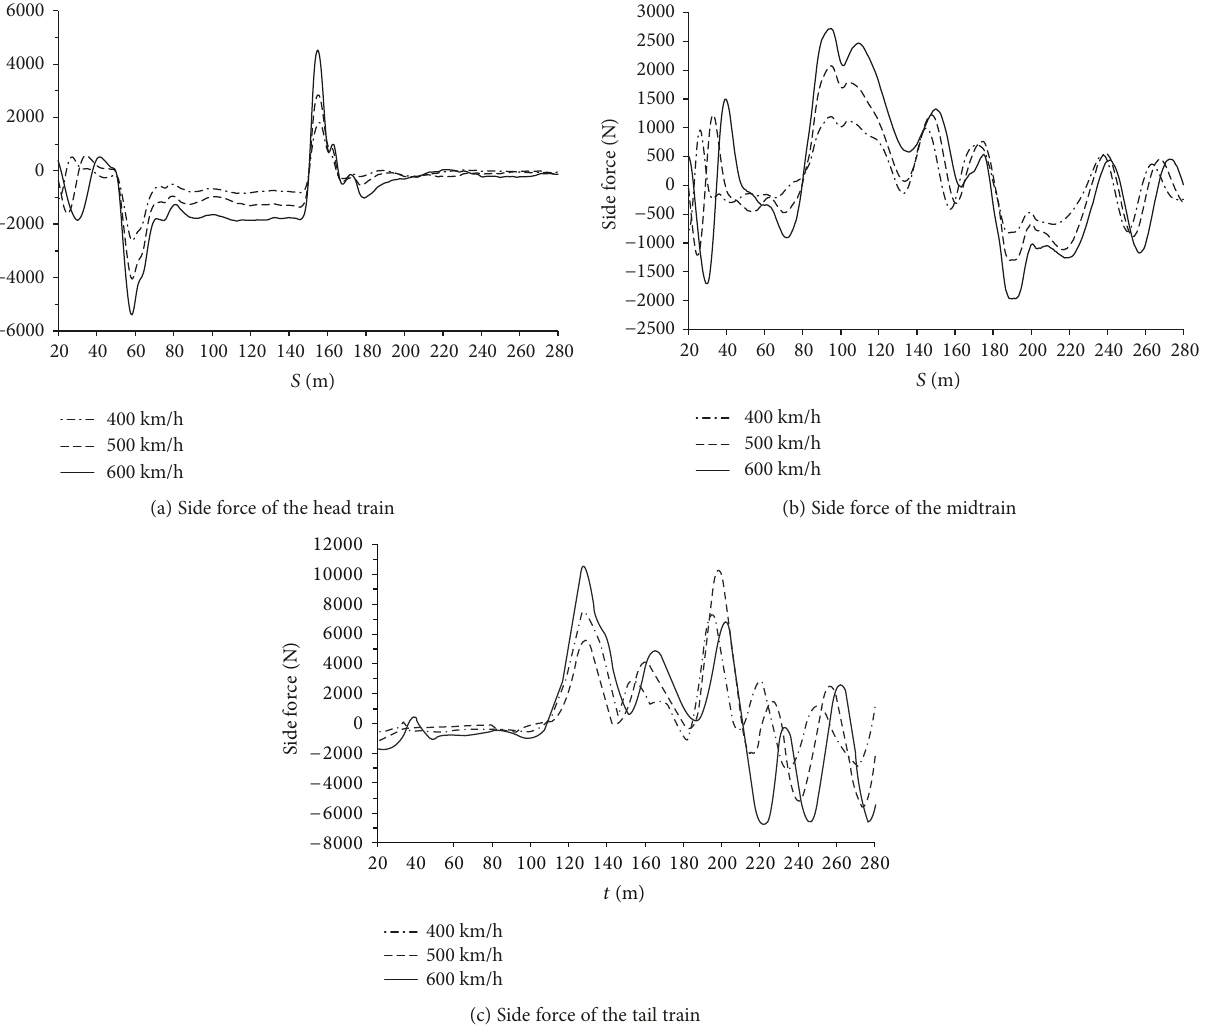
Figure 17: Changing of aerodynamic side force of each train